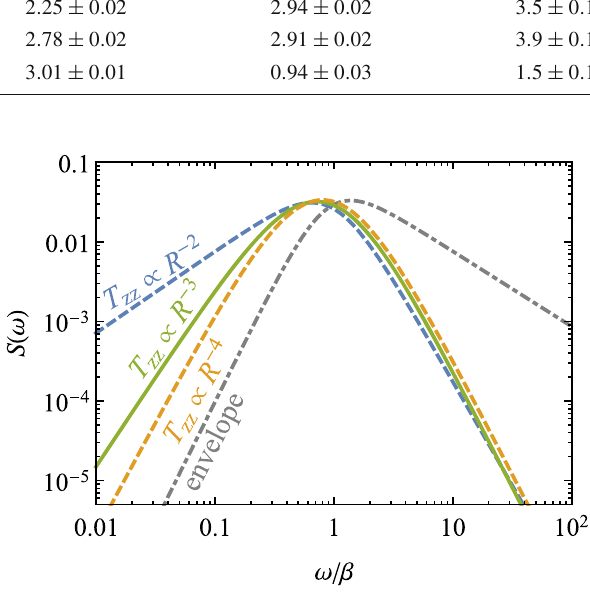
Fig. 3 ThespectralshapeofGWs(seeEq.(B13))fromvacuumbubble collisions. The curves show broken power-law fits to the simulation results for different decay-laws of the GW source after collisions and in the envelope approximation. The solid curve is realised in the case of breaking of a gauge U(1) symmetry. The corresponding parameters of the fit, and their errors, are given in Table